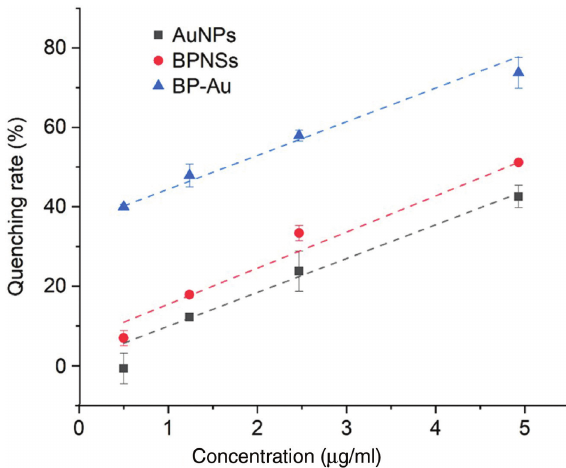
Figure 5: Comparison of the quenching ability of different concentrations of gold nanoparticles (AuNPs), black phosphorus nanosheets (BPNSs), and the BP-Au nanocomposite.